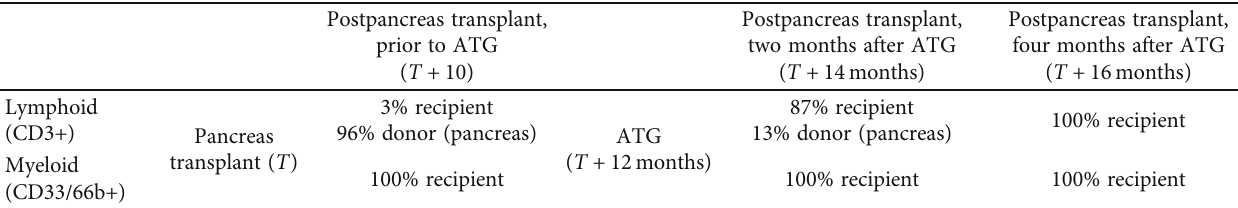
Figure 2: (a) Necrotic keratinocytes and satellitosis on a background of interface change and spongiosis suggestive of graft versus host disease in a patient with pancreas transplant. (b) Erosion composing the border of what clinically appeared to be a coronoid lamella but on microscopy is scale crust and necrotic Table 1: Chimerism data before and after ATG administration.